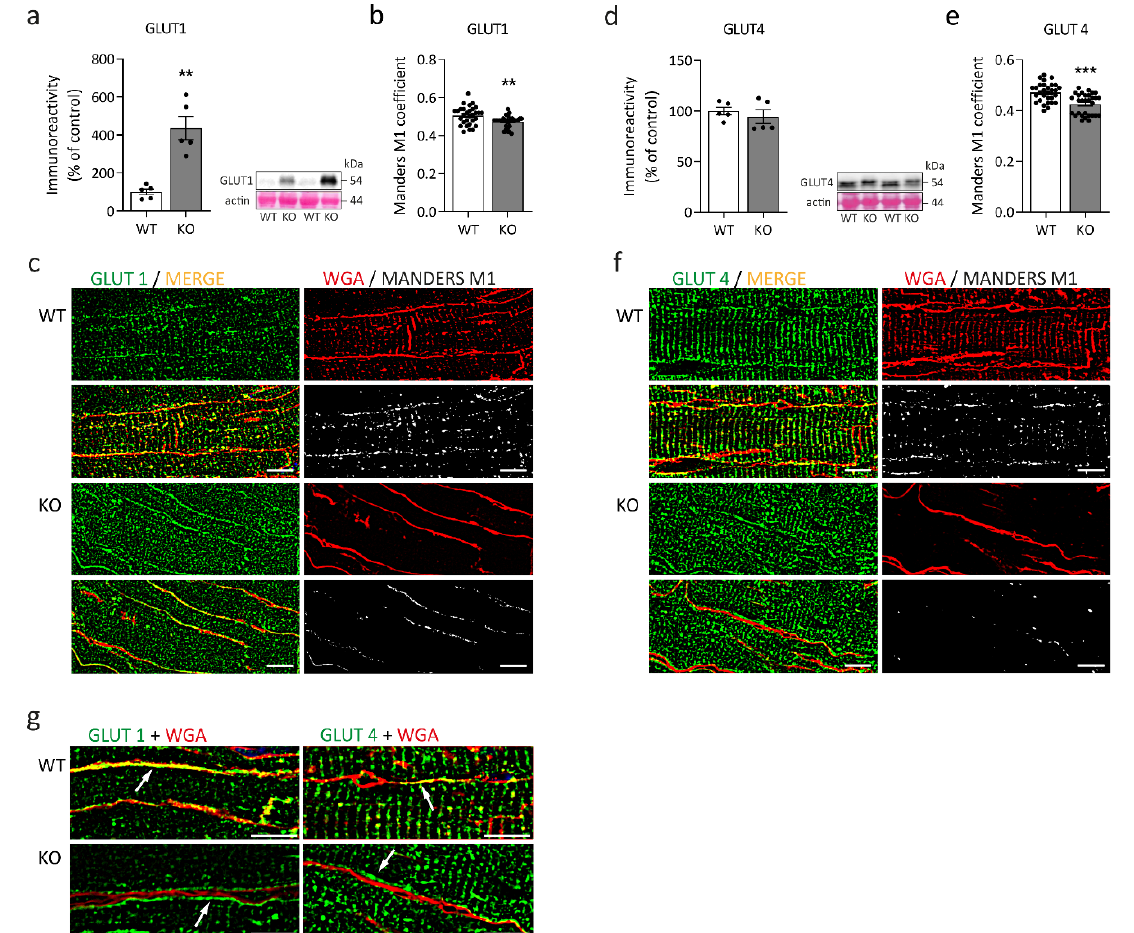
Figure 3. Expression and localization of glucose transporters in desmin knock-out cardiac tissue. ( a , d ) Immunoblot analysis addressing the expression of GLUT1 ( a ) and GLUT4 ( d ) in left ventricular cardiac tissue homogenates. Samples from five animals per genotype were immunoblotted in duplicate; Mann-Whitney test, ** p < 0.01. Representative immunoblots and Ponceau S-stained membranes are shown. The apparent molecular weight of GLUT1 and GLUT4 is 54 kDa. Note the highly increased expression of GLUT1 as well as the slight shift of the GLUT4 immunoblot signals to a higher molecular weight in desmin knock-out hearts. ( b , e ) Quantitative analysis of the colocalization of both glucose transporters with the sarcolemma based on the Manders M1 coefficient resulted in a statistically significant difference between desmin knock-out and wild-type animals (ten images of different regions of cardiac muscle tissue specimens from each of the three animals of each genotype were analyzed; Mann-Whitney test, ** p < 0.01, *** p < 0.001). Values in ( a , b , d , e ) are given as mean ± SEM. ( c , f ) The subcellular localization of GLUT1 (( c ), green) and GLUT4 (( f ), green) in relation to the sarcolemma stained by Wheat Germ Agglutinin (WGA, red) was visualized in longitudinally oriented cardiomyocytes. Note the absence of the WGA signal within the t-tubules region of sarcoplasm of the desmin knock-out cardiomyocytes (upper right images of KO). Black and white images represent colocalized pixels according to Manders M1 coefficient (white). ( g ) Qualitative examination depicted a localization of both GLUT1 and GLUT4 underneath the sarcolemma in desmin knock-out cardiomyocytes (white arrows, lower images), whereas the signals of both glucose transporters in wild-type tissue colocalized to the WGA-stained sarcolemma (white arrows, upper images). Scale bars, 10 µm.